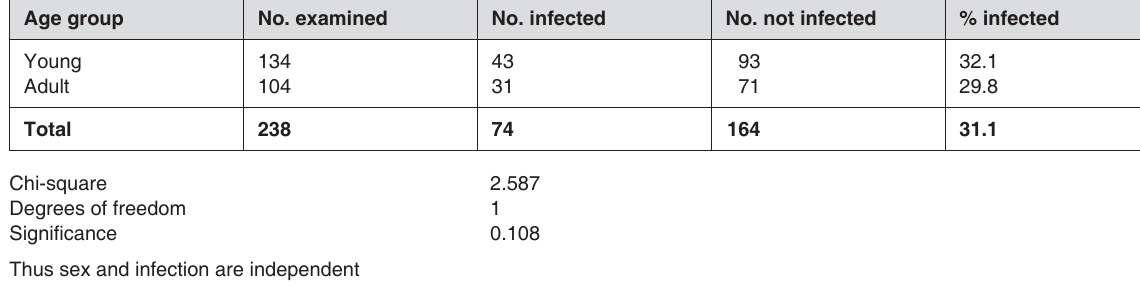
Thus sex and infection are independent TABLE 3 Distribution and percentage of fertile hydatid cysts per organ in infected feral pigs